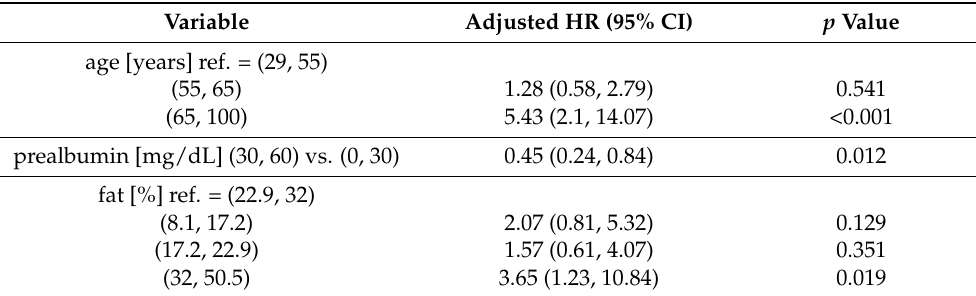
Table 4. Results of Cox’s proportional hazards analysis of survival predictors. Variable Adjusted HR (95% CI) p Value